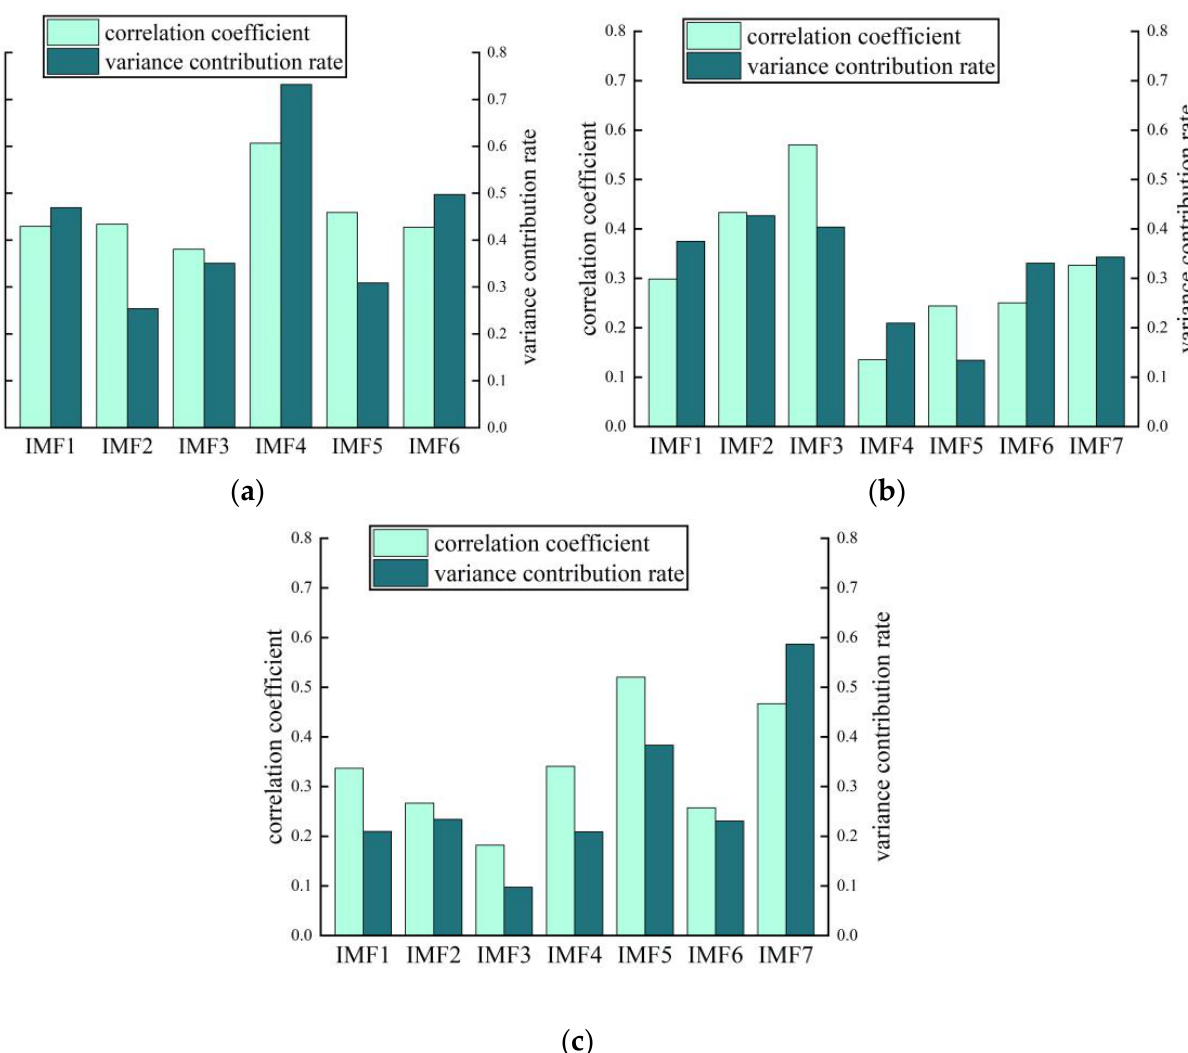
Figure 13. The correlation coefficient and variance contribution rate of three methods: ( a ) ASSME; ( b ) CSSVMD; ( c ) CSSEWT .